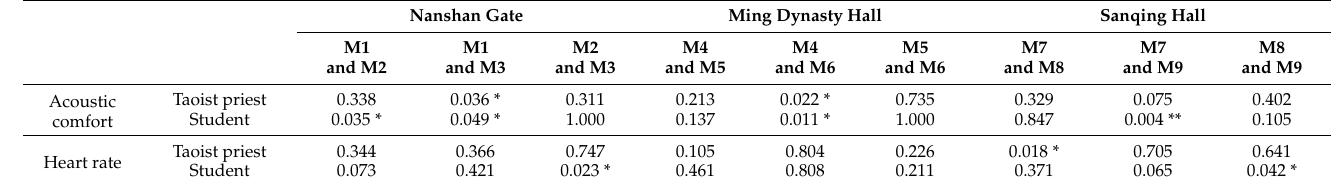
Table 3. Significant differences for acoustic comfort and heart rate of Taoist priests and ordinary people between two different sounds under the same scene of Laojundong temple, emerging from Kruskal–Wallis test and ANOVA for repeated measurement test, respectively (* p < 0.05, ** p < 0.01). Nanshan